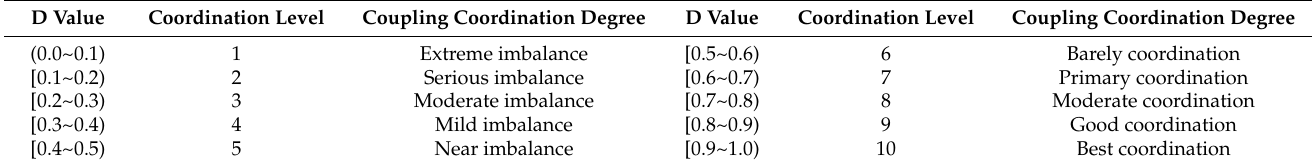
Table 3. Standard for grading coupling coordination